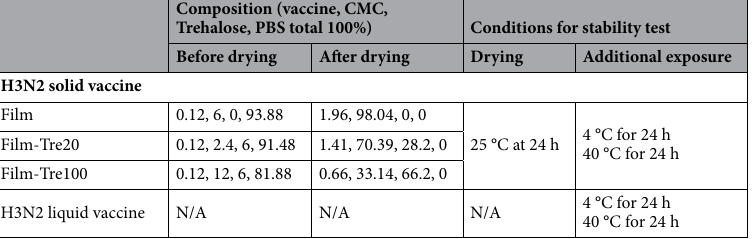
Table 2. Information on H3N2 vaccine films for stability test using RP-HPLC and ELISA